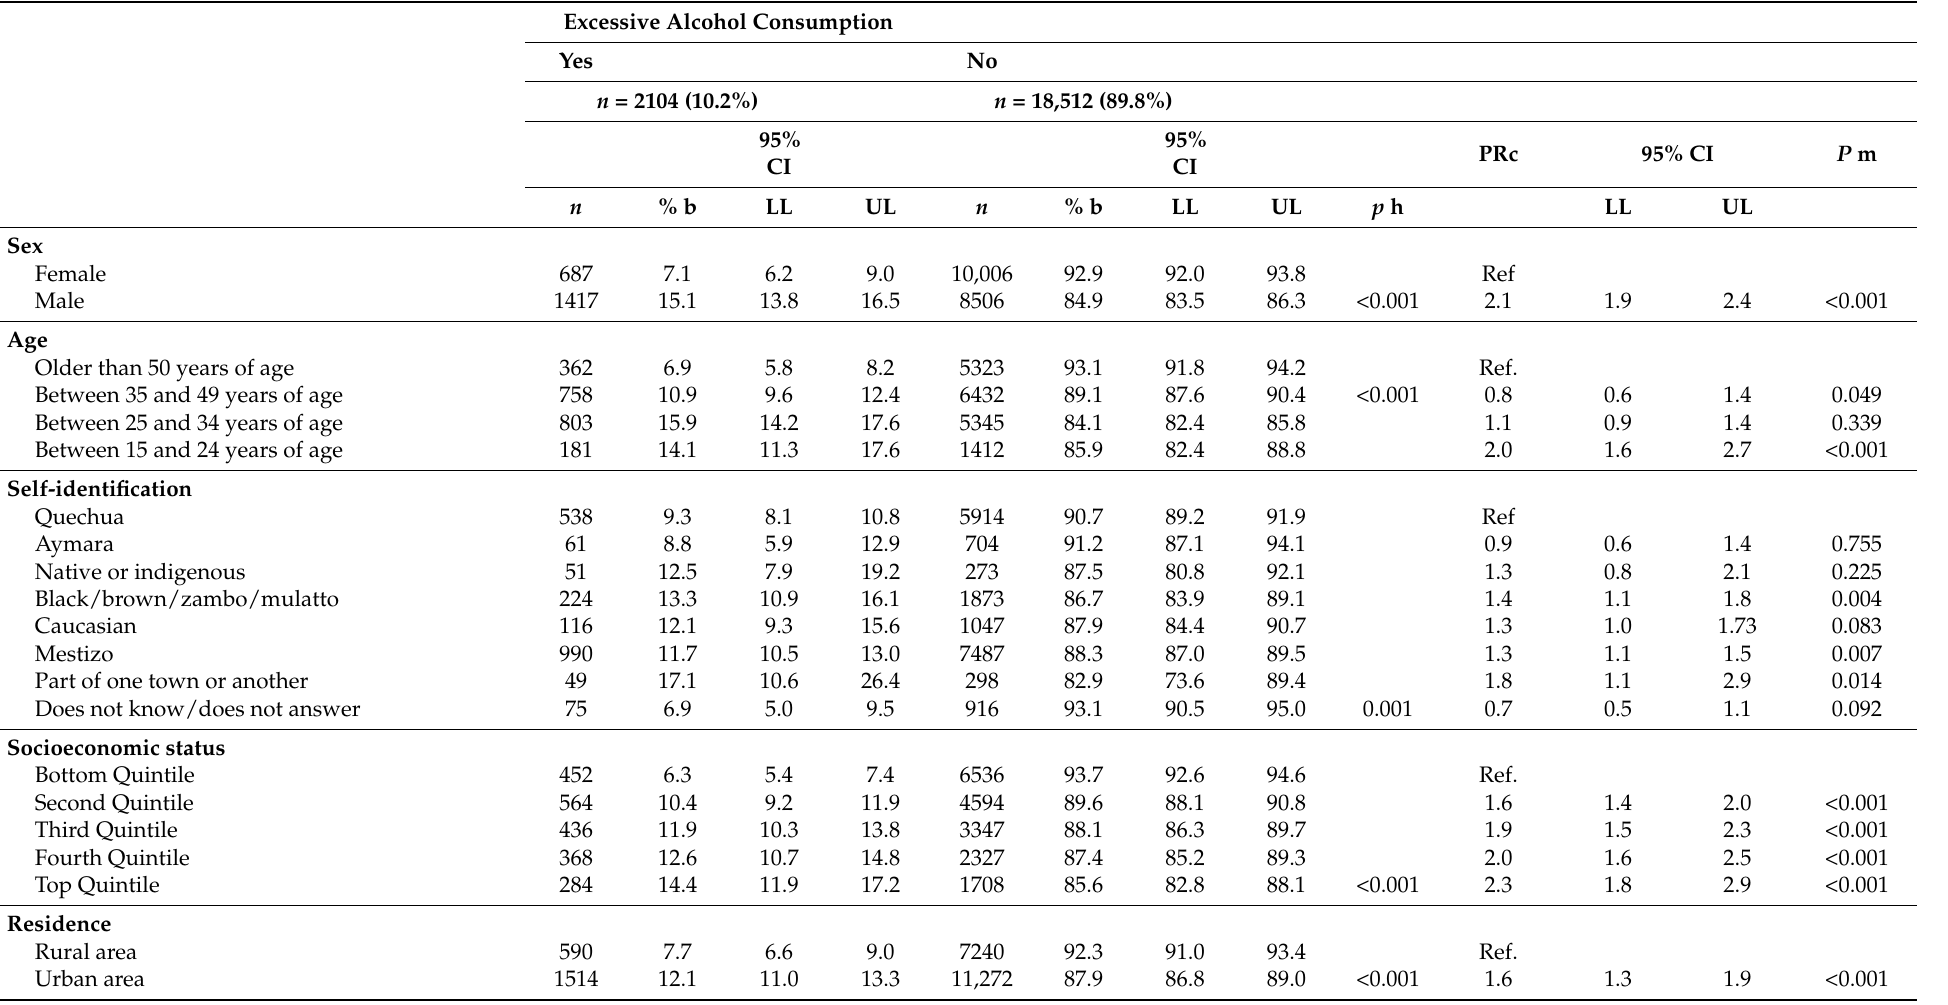
Table 3. Association between sociodemographic characteristics and excessive alcohol consumption in individuals ( n =